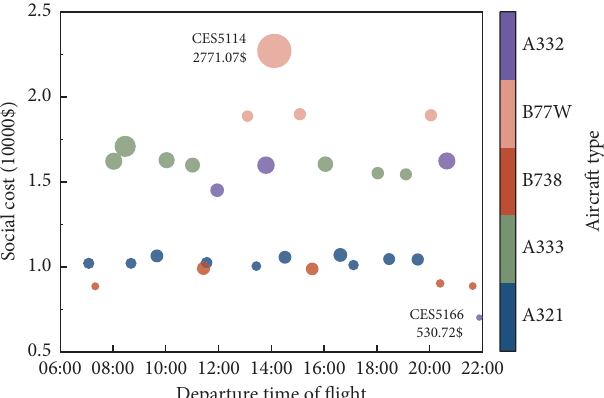
Figure 5: The social cost of 30 flights on December 1, 2020, and their results about comprehensive benefits from